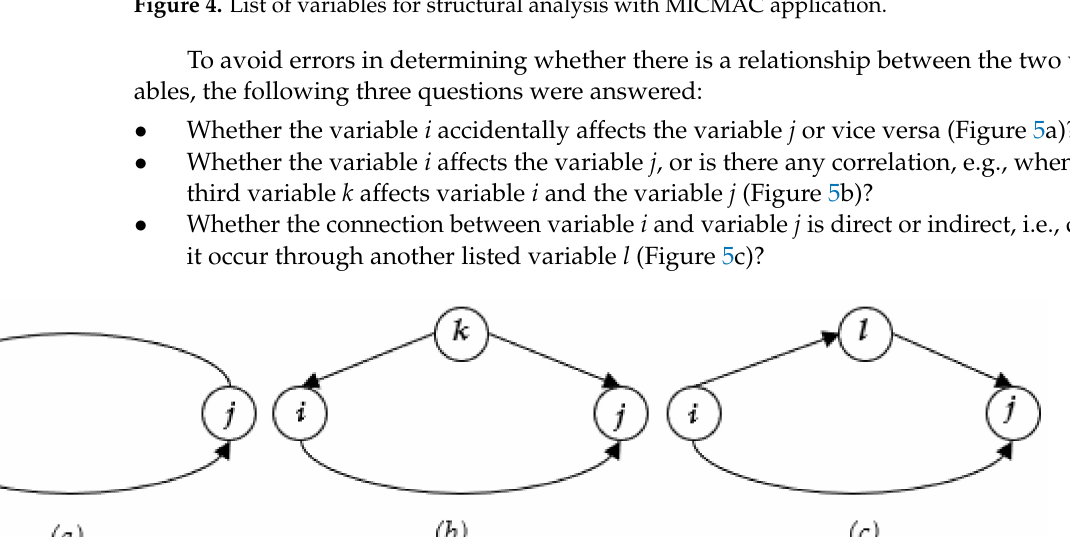
Figure 4. List of variables for structural analysis with MICMAC application.